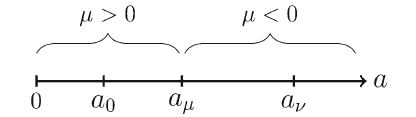
Fig. 1 Schematic illustration of the relation between the scale factor and the parameter μ . The points a μ and a ν represent the cases μ = 0 and ν = 0 ( μ = − 1), respectively; a 0 stands for the present value of the scale factor